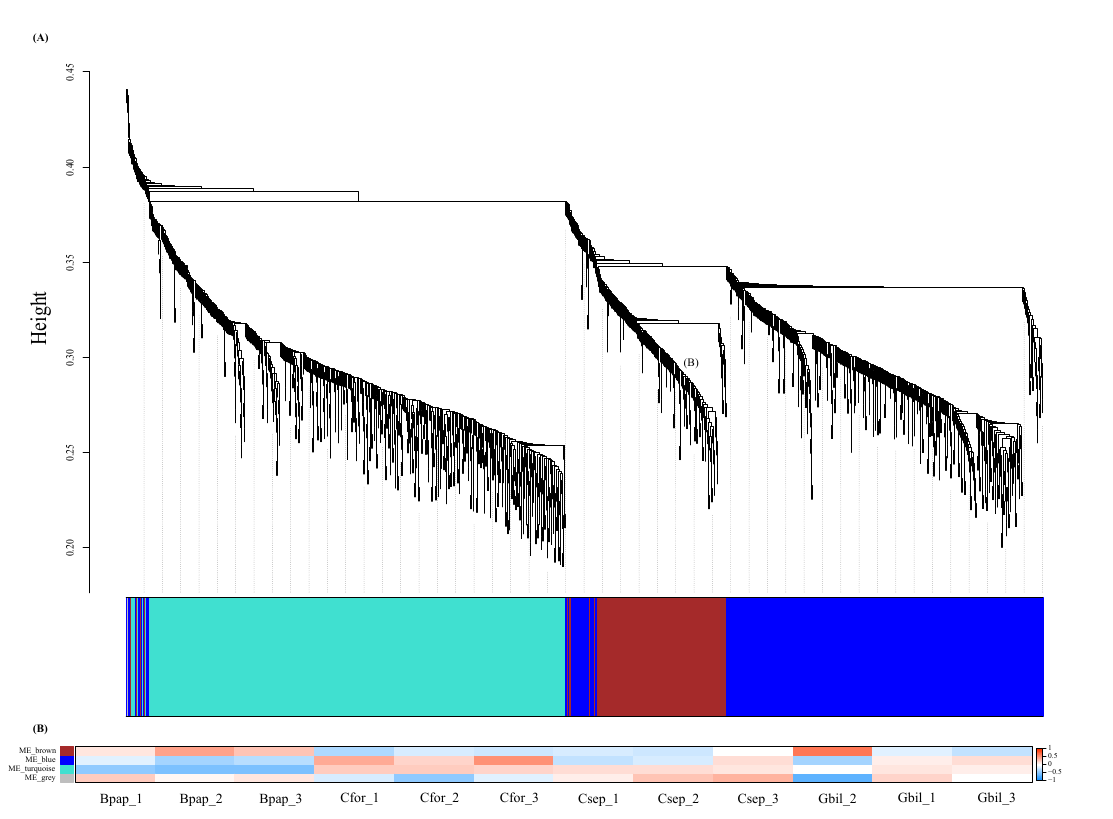
Figure 4. Weighted gene co-expression network analysis (WGCNA) in all samples. ( A ) Hierarchical clustering tree (dendrogram) of unigenes. ( B ) Heatmap showing the comparison of modules among all